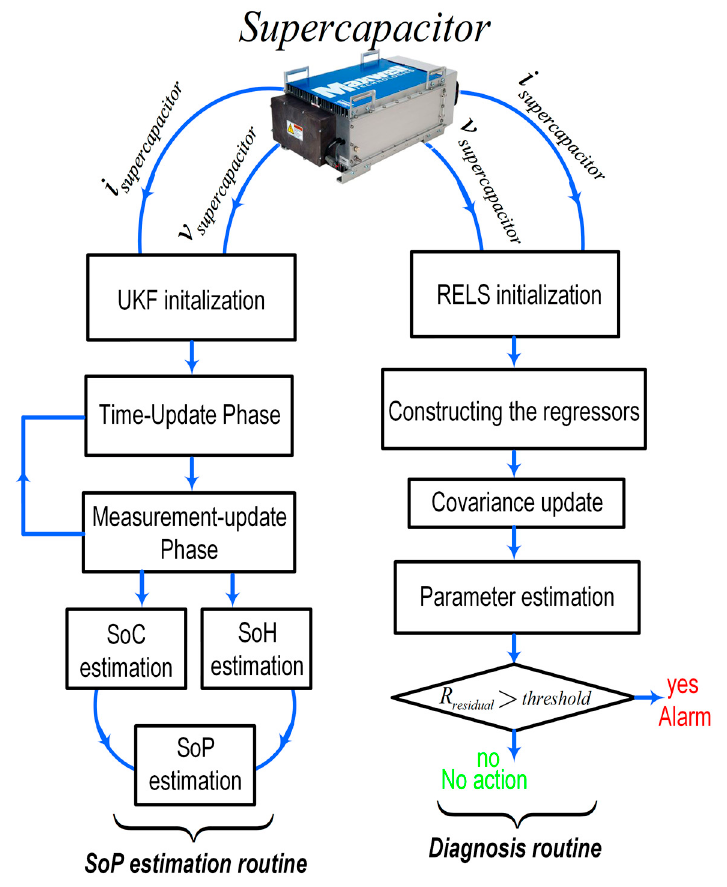
Figure 2. SoF estimation and diagnosis of the supercapacitor in the AEV.